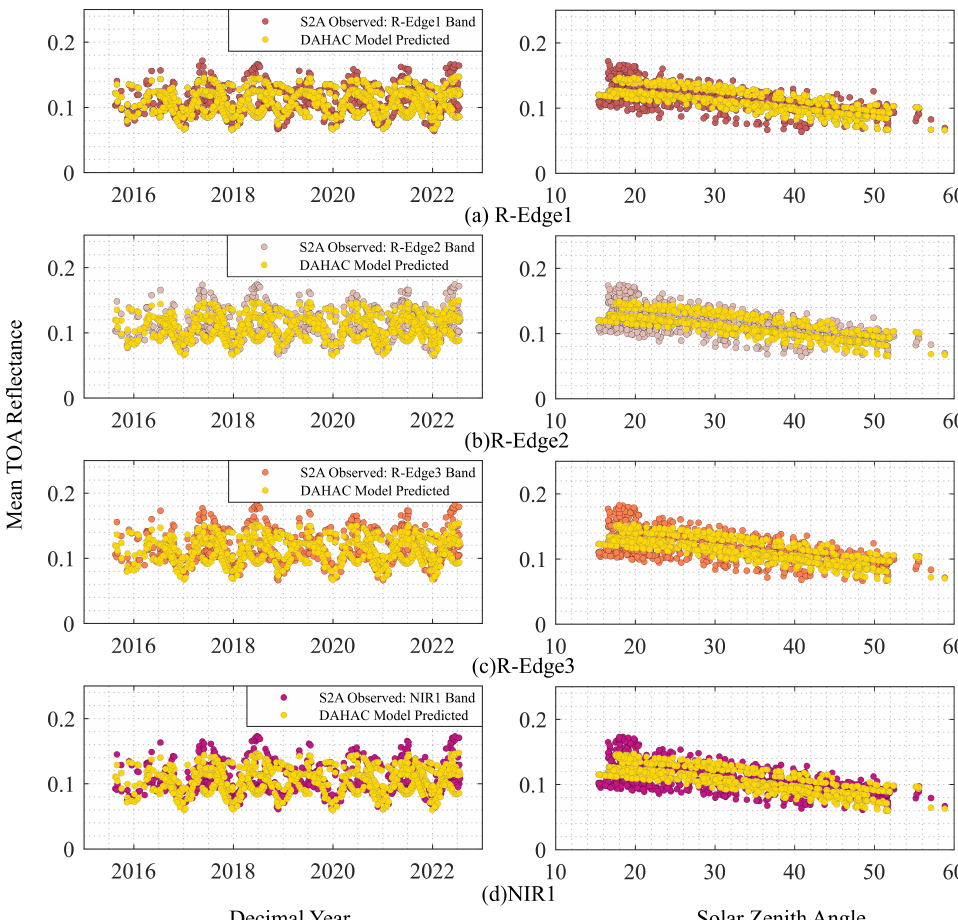
Figure 22. DAHAC model validation on S2A for non-Landsat bands.